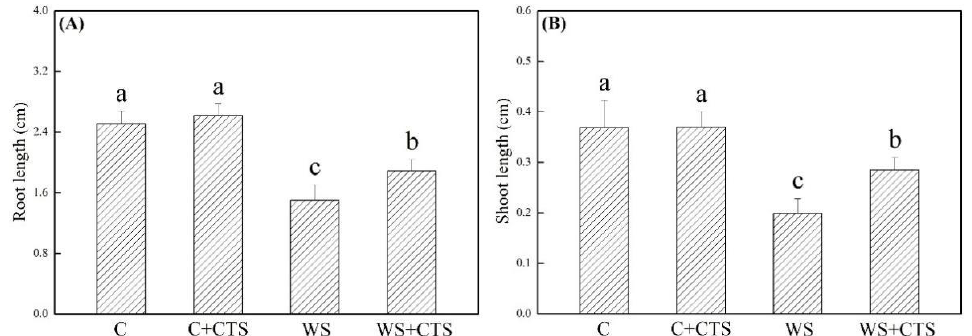
Figure 3. Seed priming with chitosan affected ( A ) seedling root length and ( B ) seedling shoot length after 7 days of germination under water stress. Vertical bars above columns indicate ± SE of mean, and different letters above columns indicate significant difference ( p < 0.05). C, control (seeds pretreated with H 2 O germinated under normal condition); C+CTS, control + CTS (seeds pretreated with CTS germinated under normal condition); WS, water stress (seeds pretreated with H 2 O germinated under water stress condition); WS+CTS, water stress + CTS (seeds pretreated with CTS germinated under water stress condition).